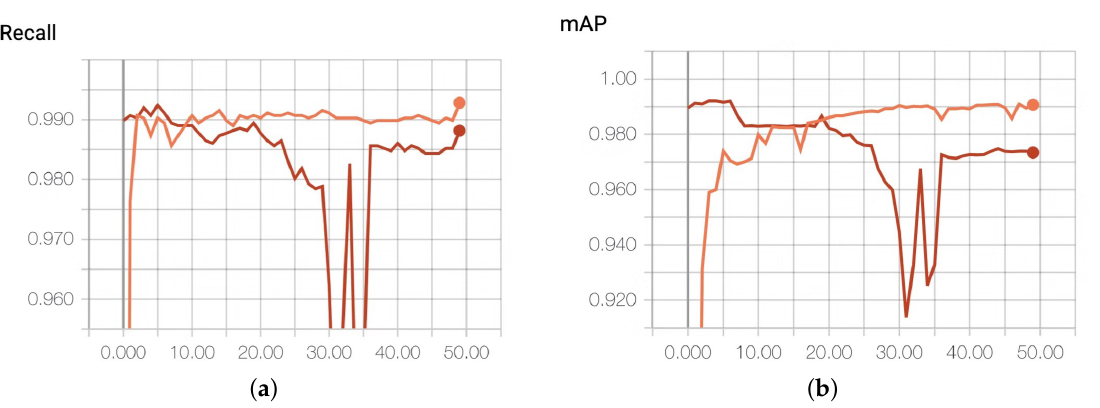
Figure 9. Average recall (AR) and mean average precision (MAP) during normal training and sparse training. ( a ) AR curves. ( b ) MAP curves.